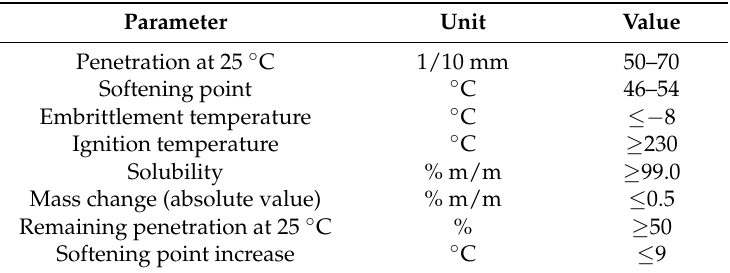
Table 2. Parameters of road asphalt 50/70.